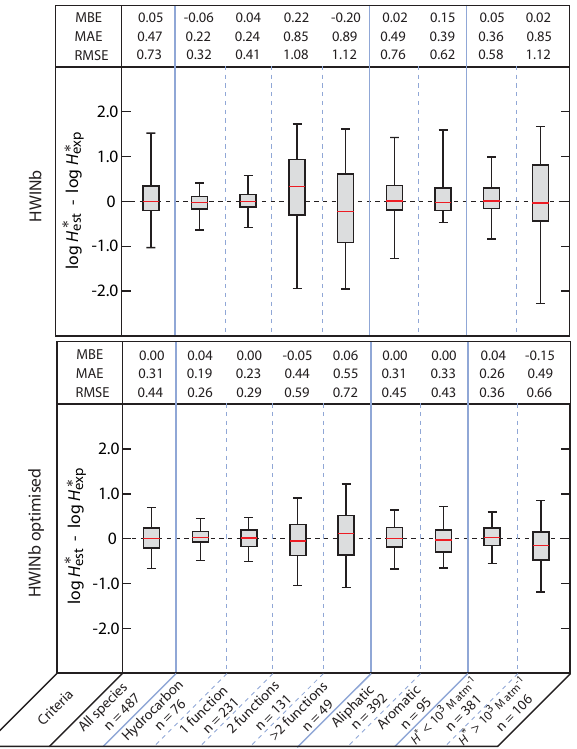
Fig. 5. Mean bias error (MBE), mean absolute error (MAE), root mean square error (RMSE) and box plot for the error distribution in the estimated log H ∗ value with the HWINb (top panel) and HWINb optimised method (bottom panel). The whiskers of the box plot show the 5th and 95th percentiles, the box shows the second and third quartile and the red line gives the median value of the distri-